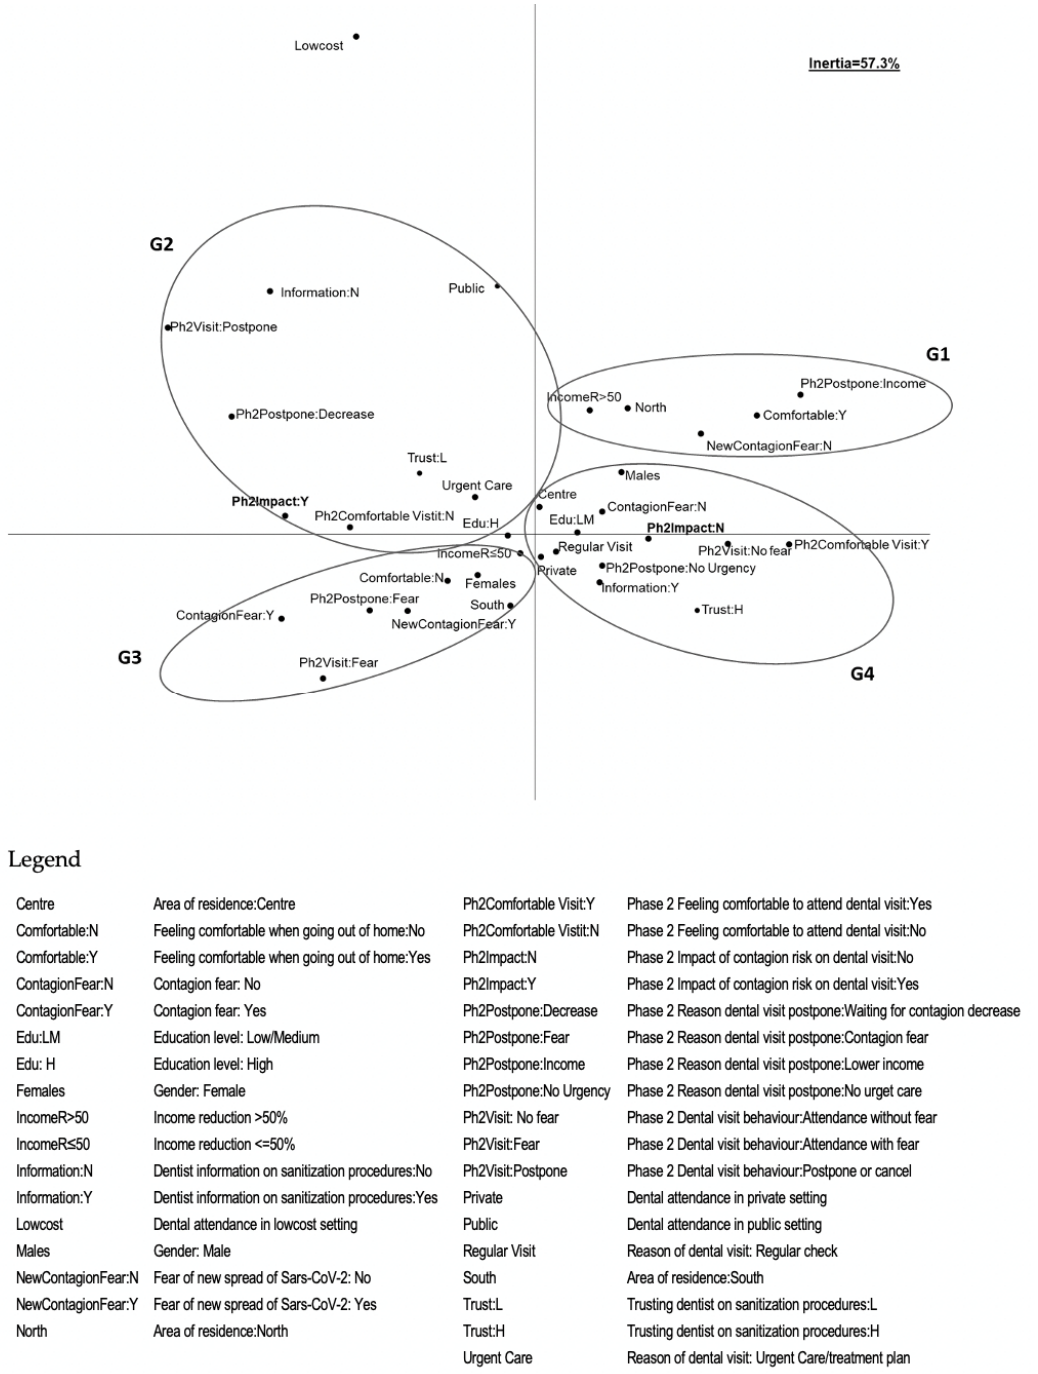
Figure 1. Association between socio-demographic characteristics, dental care access, the fear of severe acute respiratory syndrome coronavirus-2 (SARS-CoV-2) contagion during Phase 1, the approach with dental care visit during Phase 2, the perception of the impact of the risk of contagion on dental care and trust in dentists regarding sanitization procedures. Results of the Multiple Correspondence Analysis (MCA): briefly, G1 group is characterized by subjects coming from North Italy that are not afraid of a new spread of the virus; G2 group identifies subjects with high level of education that would not feel comfortable in undergoing a dental appointment; G3 group refers to subjects coming from South Italy that would postpone a dental appointment; G4 group includes subjects with low or medium level of education that would feel comfortable in undergoing a dental appointment.